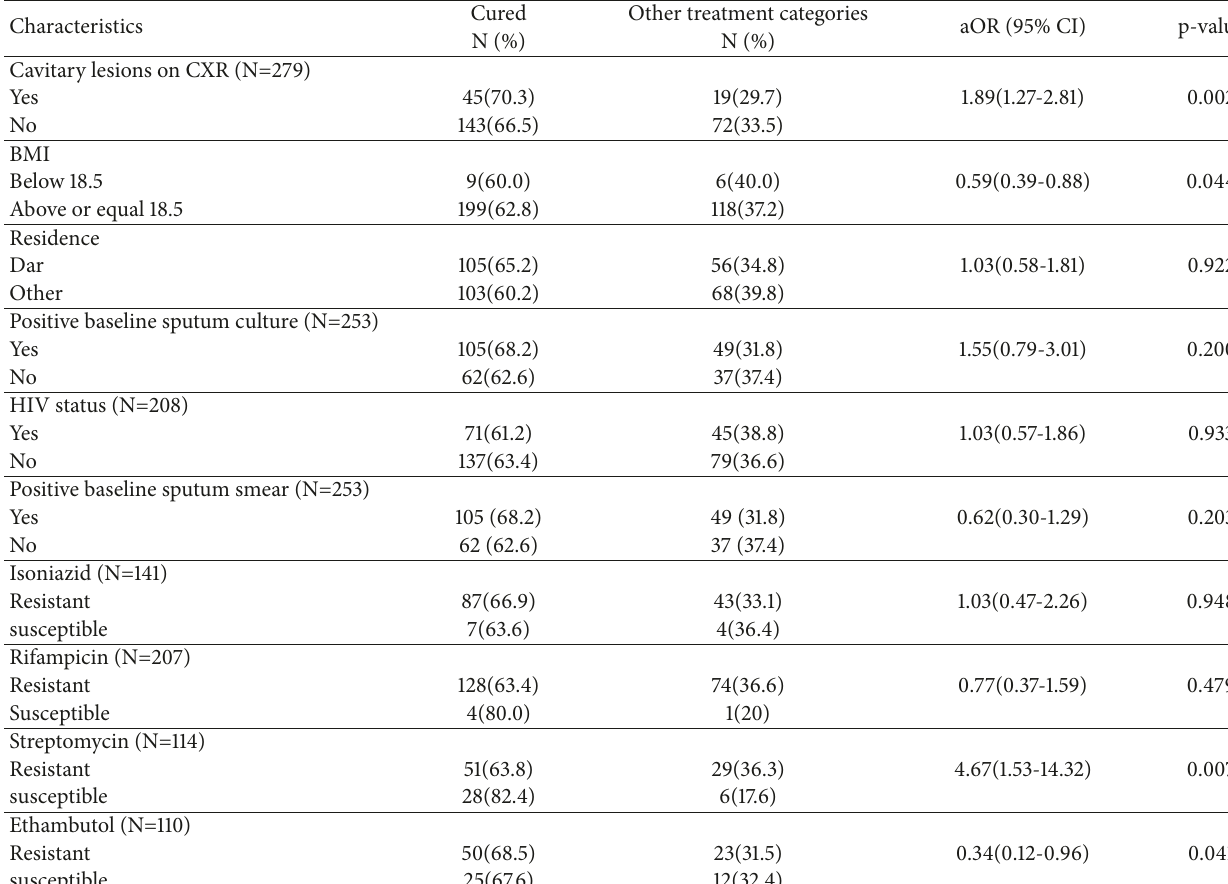
Table 4: Adjusted OR after multivariate analysis for predictors of treatment outcome of cure.